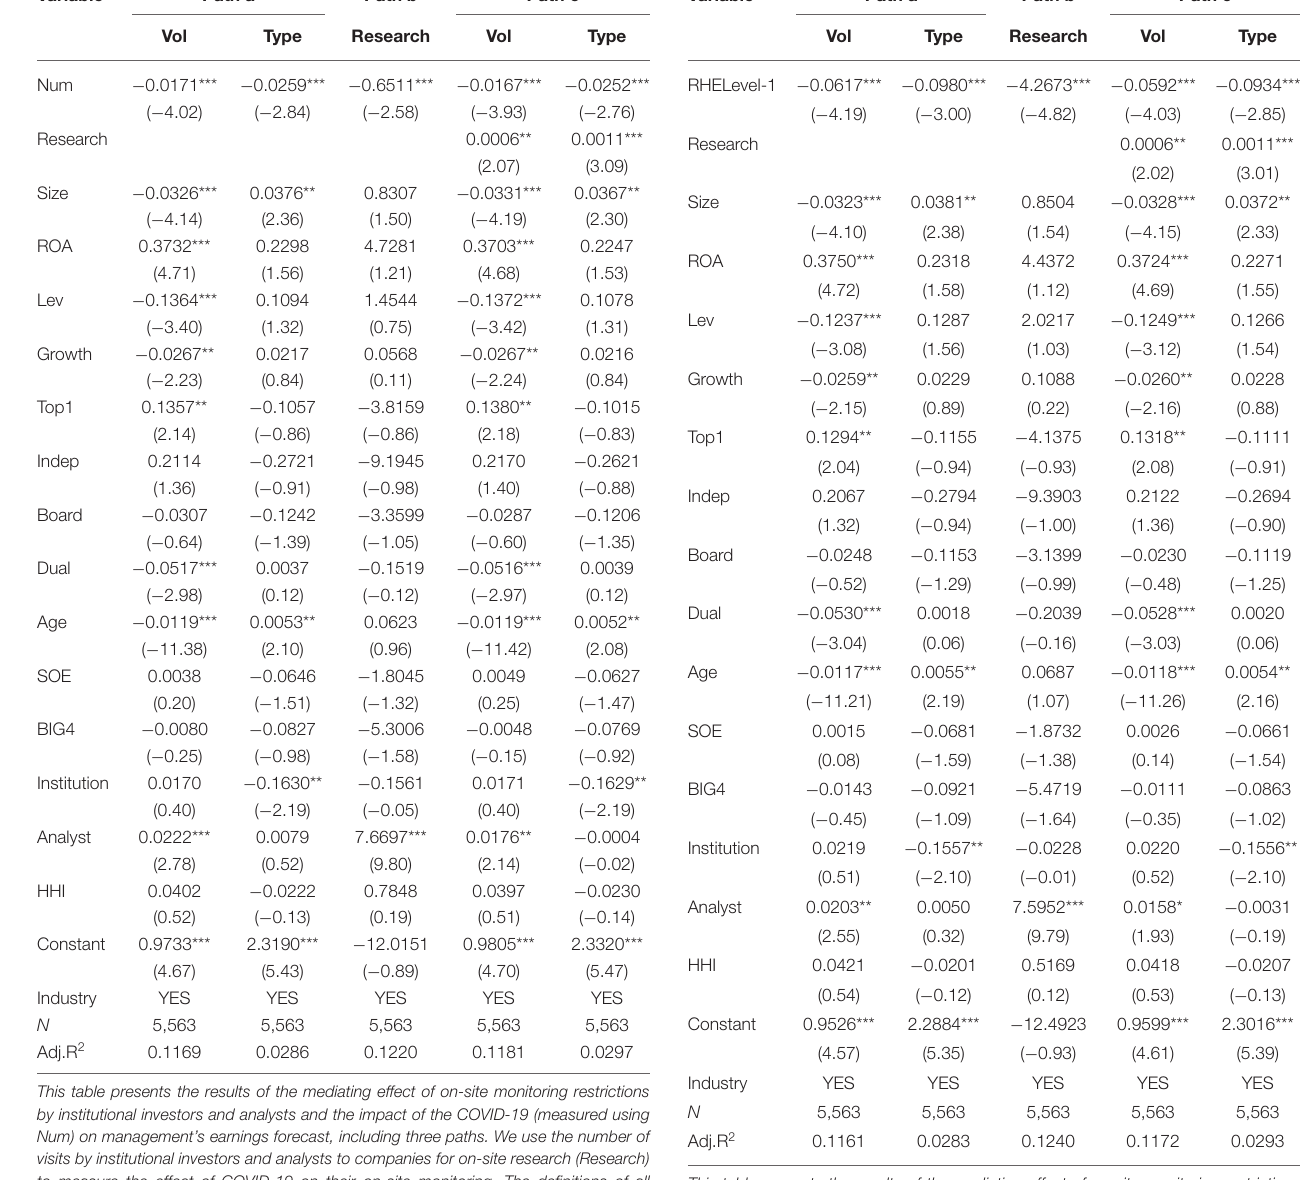
TABLE 9 | Evidence on the impact of on-site monitoring restrictions by institutional investors and analysts (X = RHELevel-1).